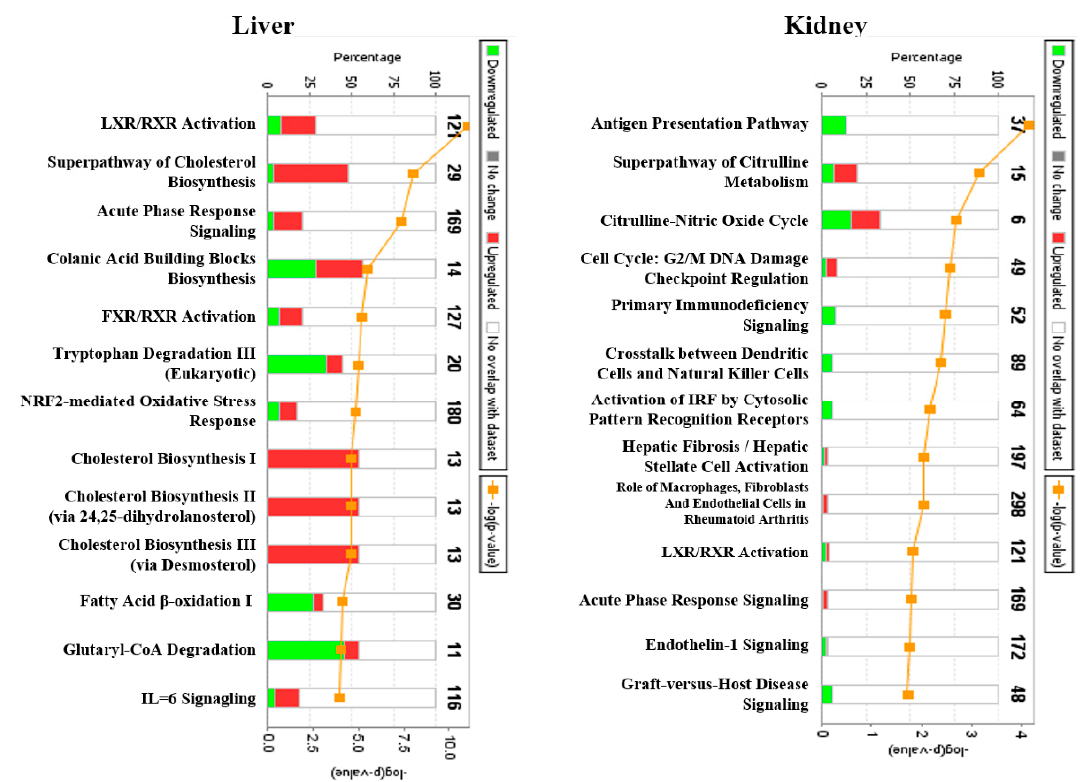
Figure 2. Top regulated canonical pathway analysis associated with 1-week consecutive ifosfamide (100 mg/kg) treatment. Each group of genes was selected based on a ≥ 1.5-fold change (9 < 0.05) cutoff using the GeneSpring program. The p -values were calculated based on Fisher’s exact test from the Ingenuity Pathways knowledge database.